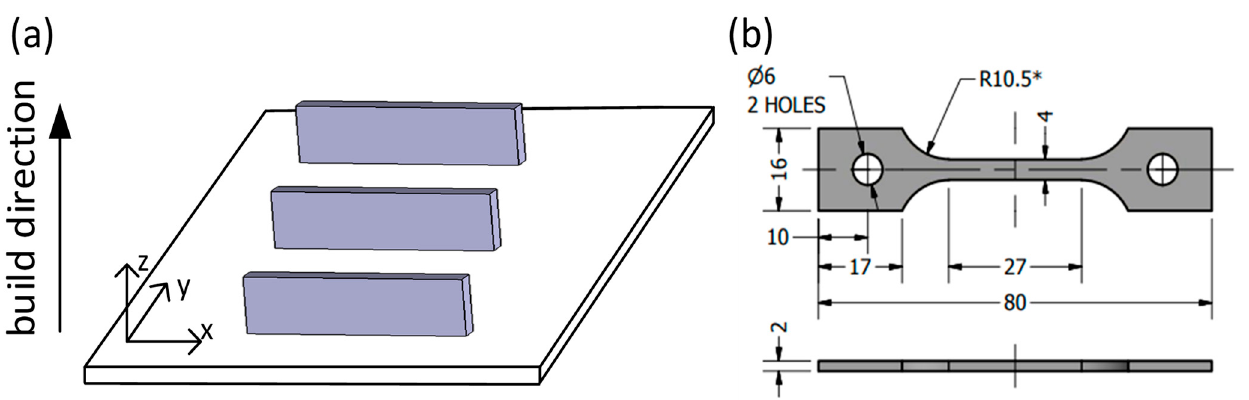
Figure 1. ( a ) Specimen orientations during processing; ( b ) tensile specimens machined from prismatic rectangular blanks (dimensions in mm; *—applicable for all gauge section radii).